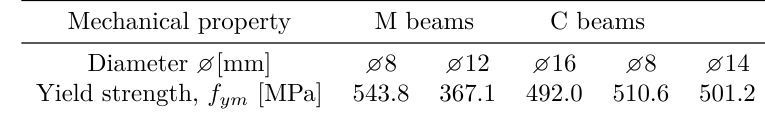
Table 3. Mechanical and geometrical property of internal steel reinforcement.